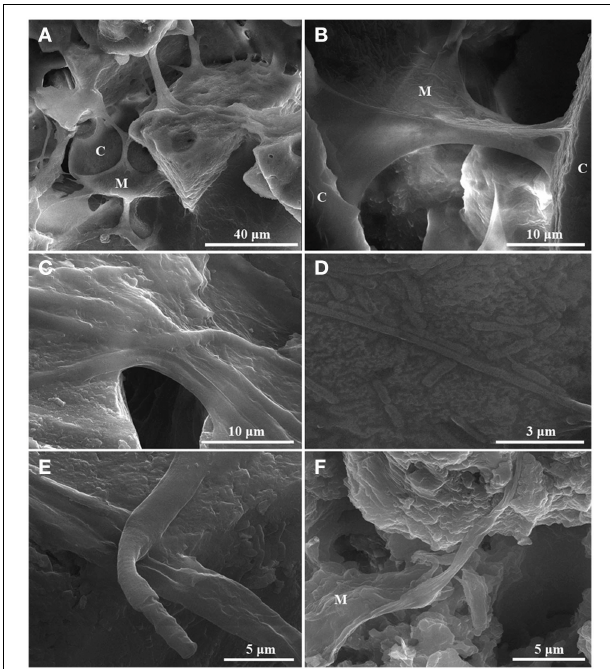
FIGURE 3 | Scanning electron microscopy images presenting the microbial mat-crystals interaction in the carbonate deposits from Ciocaia. (A) The microbial mat traps and binds the crystals (C32). (B) The microbial mats form connecting bridges between crystals (observed in C49 and rarely in C65). (C,D) The microbial mat or the individual bacterial filaments or rods colonizing the mineral deposit ( C —C32; D —C65). (E,F) Individual filaments ( E —C32), as well as the entire microbial biofilms ( F —C49) are included in what appears to be a thick mass of extracellular polymeric substances. M, microbial mat; C, carbonate